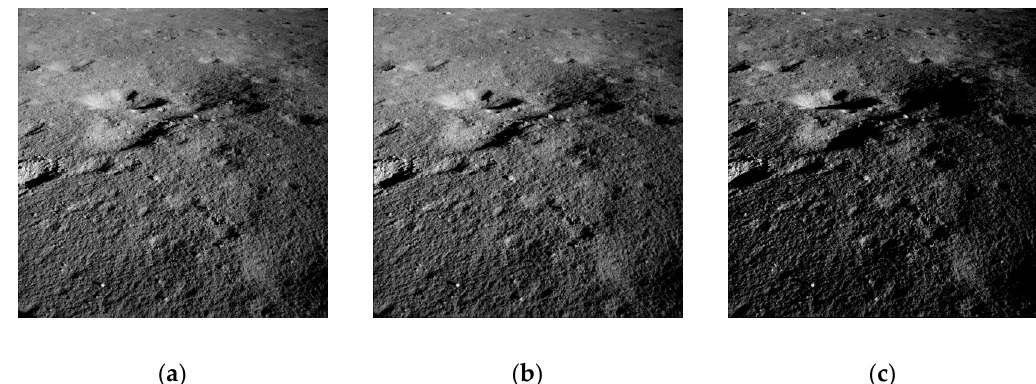
Figure 11. Navcam images of the left camera under different illumination conditions ( a ) 94741, ( b ) 94914, ( c ) 95633. Table 4. Illumination conditions of the images used in the experiment.